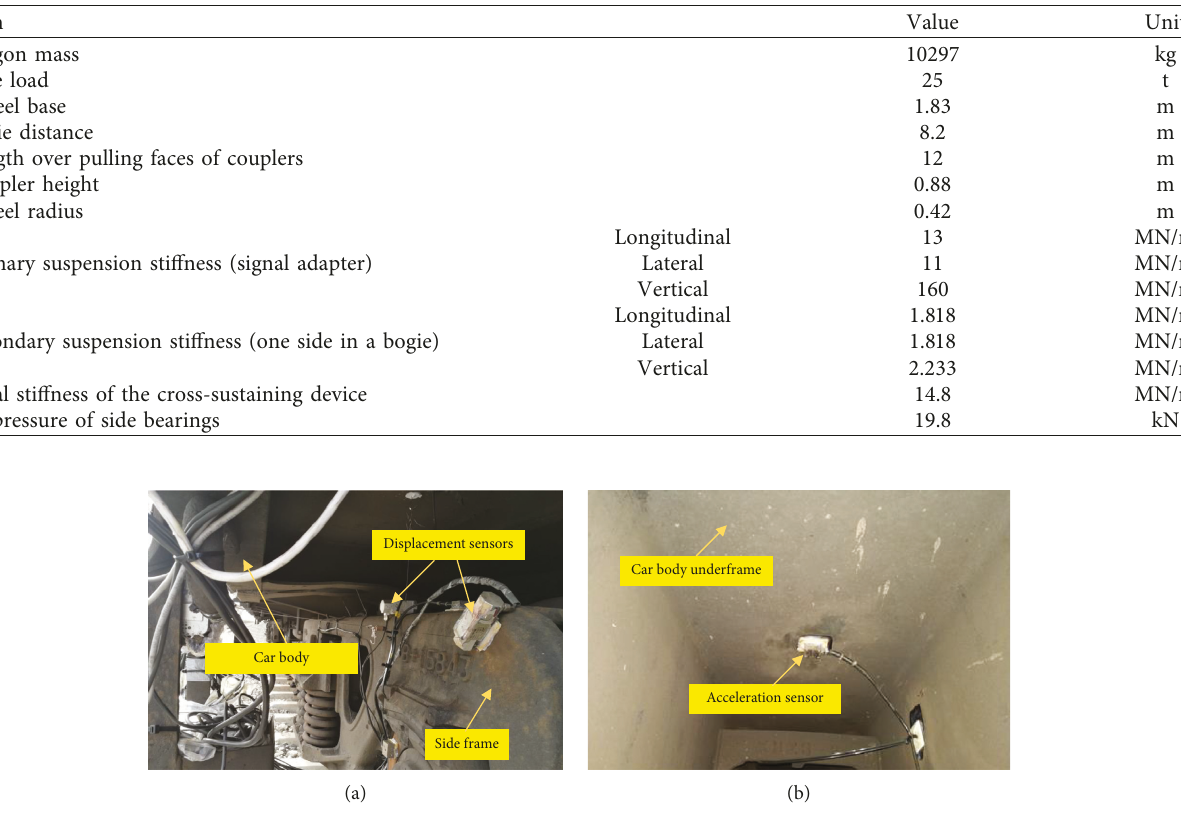
Figure 8: Wedge suspension of the K6-type bogie: (a) structure diagram; (b) dynamic model; (c) details of the wedges and the coil spring groups. Table 2: The main parameters of empty C 80 -type gondola.